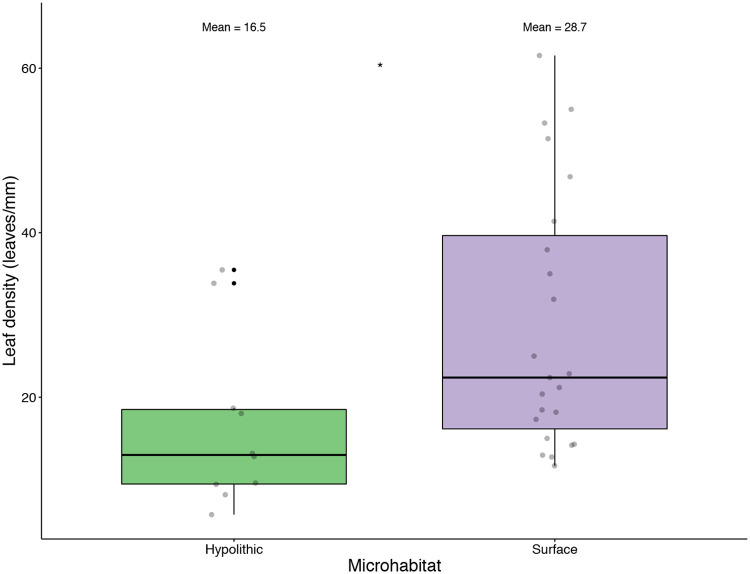
Differential leaf density in Syntrichia caninervis shoots from hypolithic and soil surface microhabitats.Box plot of hypolithic and soil surface S. caninervis leaf density. * Wilcoxon test, P = 0.0125. MeanHYP = 16.5 leaves/mm, meanSUR = 28.7 leaves/mm; nHYP = 10, nSUR = 23.